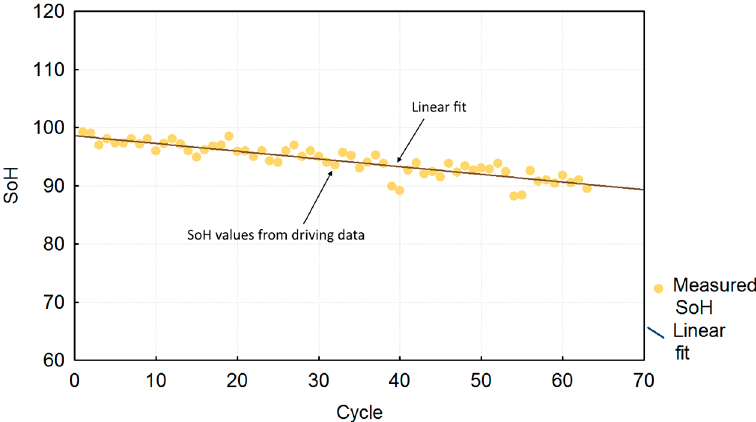
Figure 10. Determining the instantaneous battery power transfer W for one discharge cycle from battery voltage and current measurements.